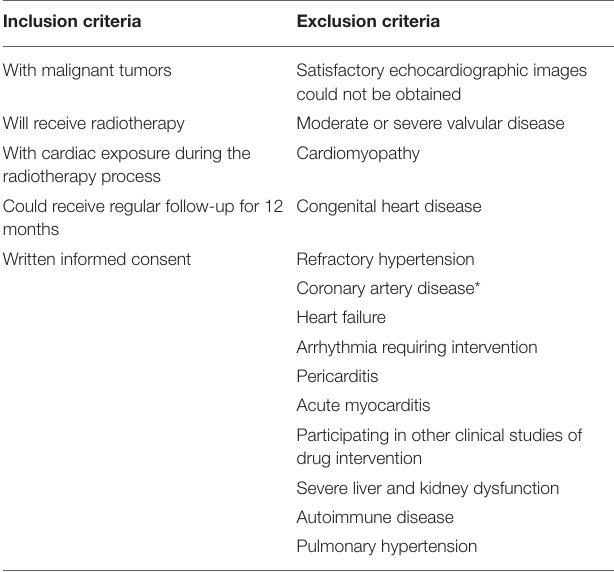
TABLE 1 | Inclusion and exclusion criteria.